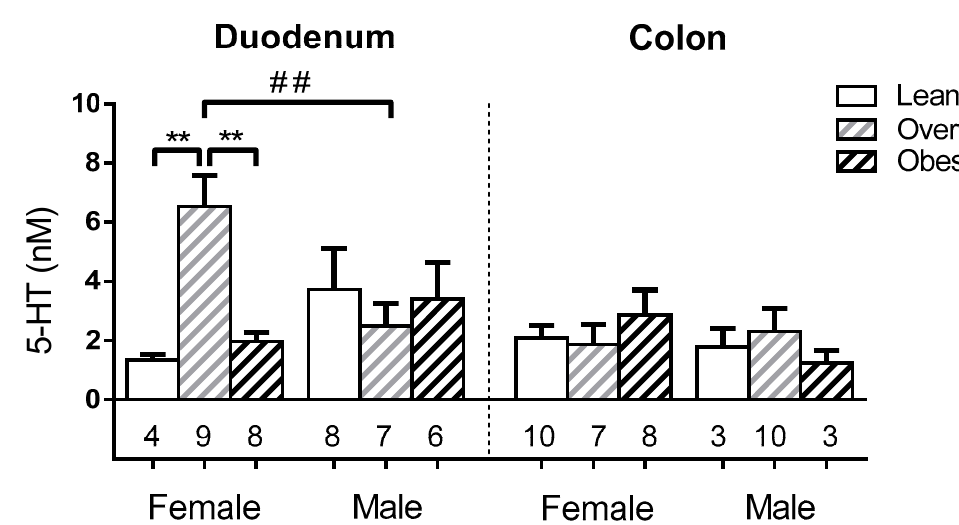
Figure 4. 5-HT content is increased only in duodenal EC cells from overweight females. Comparison of the 5-HT content in EC cells by sex, BMI category, and gut region. The number of patients in each group (N) is shown under each bar. * and # represent significant differences in the duodenum, in a two-way ANOVA considering sex and BMI category with Holm-Sidak’s multiple comparison test. * represents significant differences between BMI categories; # represents significant differences between sexes. p < 0.01 (**, ##).